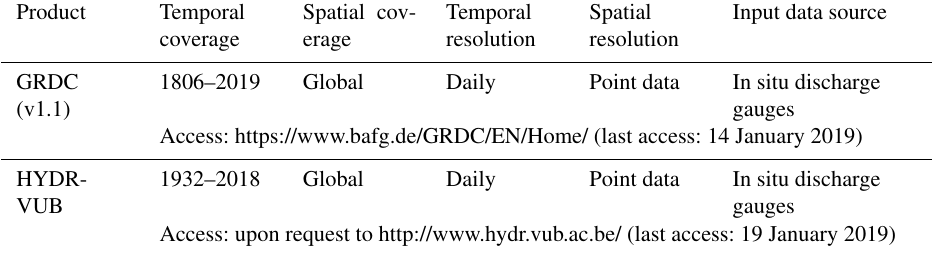
Table 4. Characteristics of discharge data.